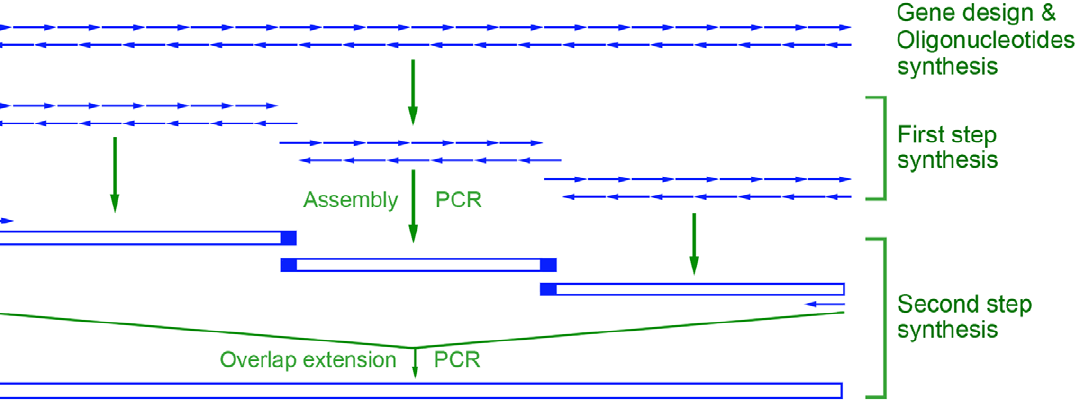
Figure 1. Schema of the two-step gene synthesis method. In the first step, the fragments overlapped with each other was separately assembled by assembly PCR with the outside oligonucleotides as primers; and then, in the second step, were assembled into the full-length gene by overlap extension PCR with 5’- and 3’-end outside primers.